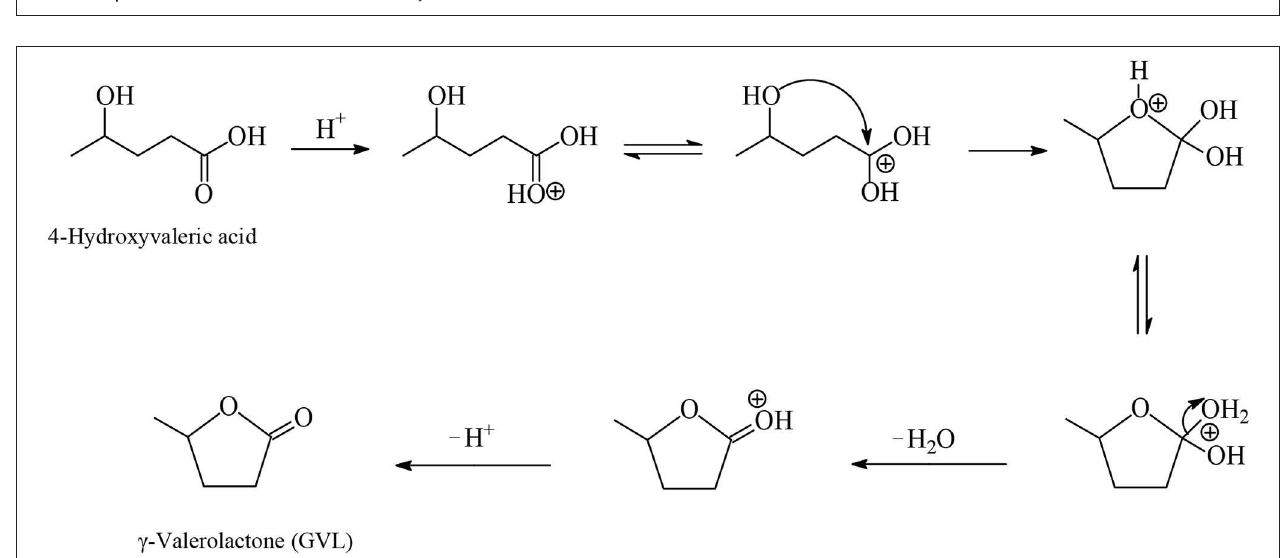
FIGURE 4 | Proposed mechanism for the dehydration of 4-hydroxyvaleric acid intermediate to yield by intramolecular esterification GVL (Ruppert et al.,